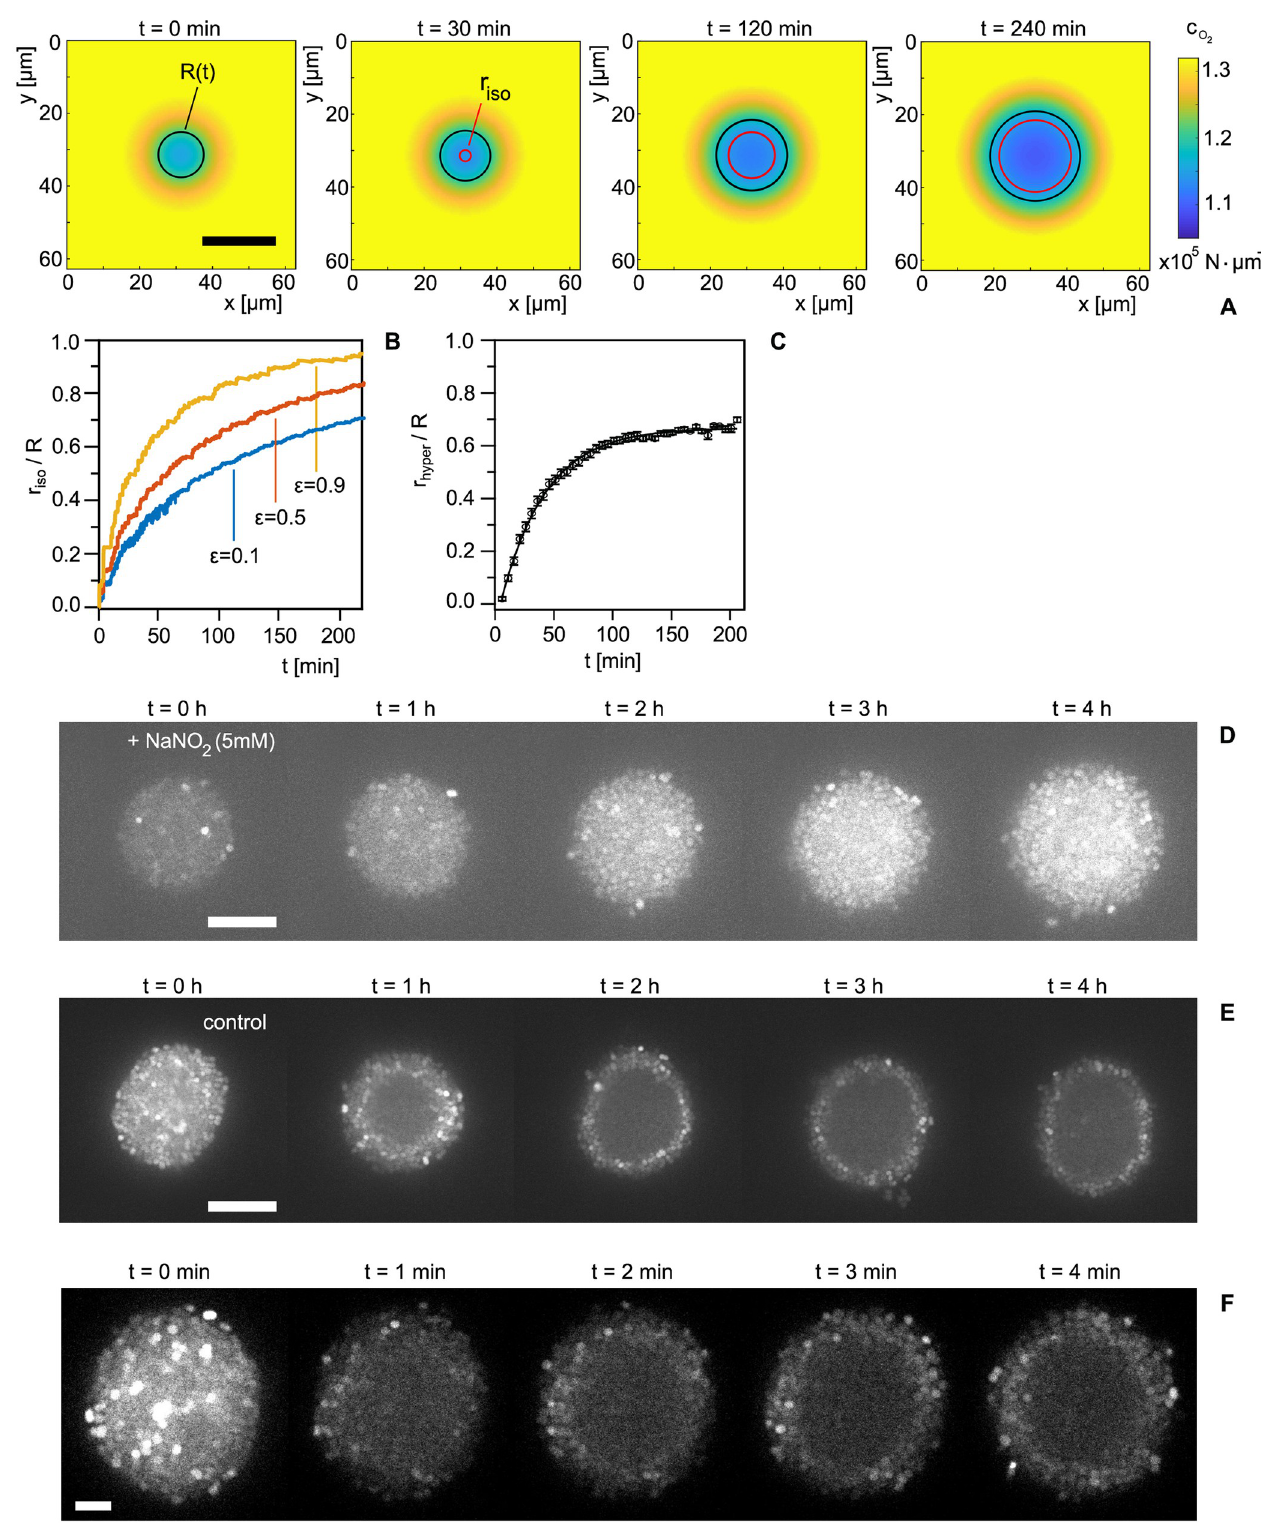
Fig 4. Simulation of oxygen gradients and addition of alternative electron acceptors suggest that oxygen depletion triggers collective hyperpolarization. AU : AbbreviationlisthasbeencompiledforthoseusedinFig 4 : Pleaseverifythatallentriesarecorrect : (A) Time lapse of simulated oxygen concentration field. Color code: oxygen concentration c